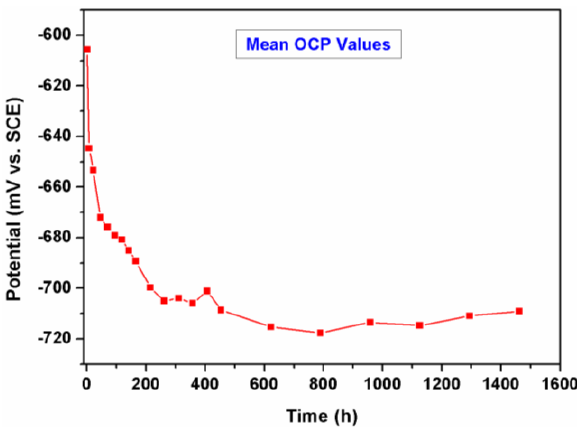
Figure 5. Mean OCP values of the coated samples during 1462 h of immersion in 3.5 wt. % NaCl